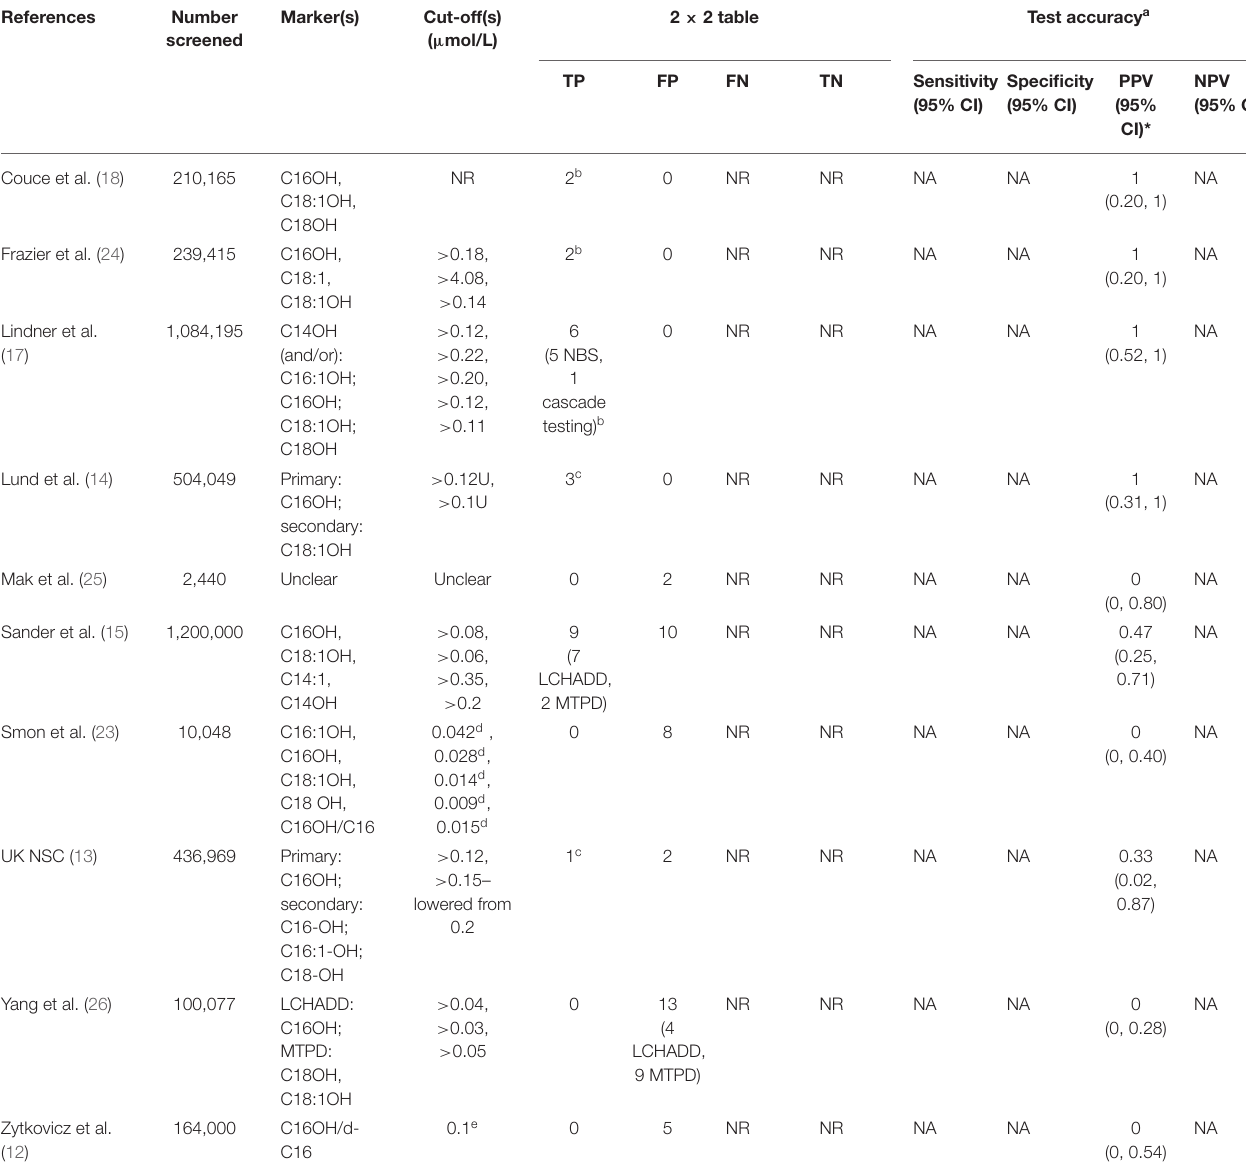
TABLE 1 | Accuracy of newborn screening tests for LCHADD/MTPD using TMS measurement of